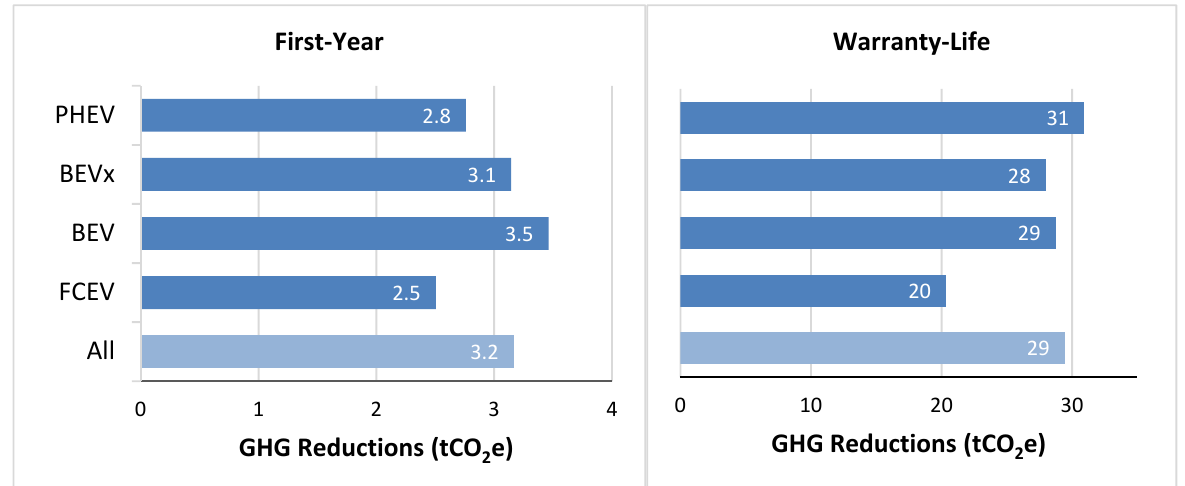
Figure 1. Per-Vehicle GHG Reduction Estimates by Technology Type and Quantification Period.